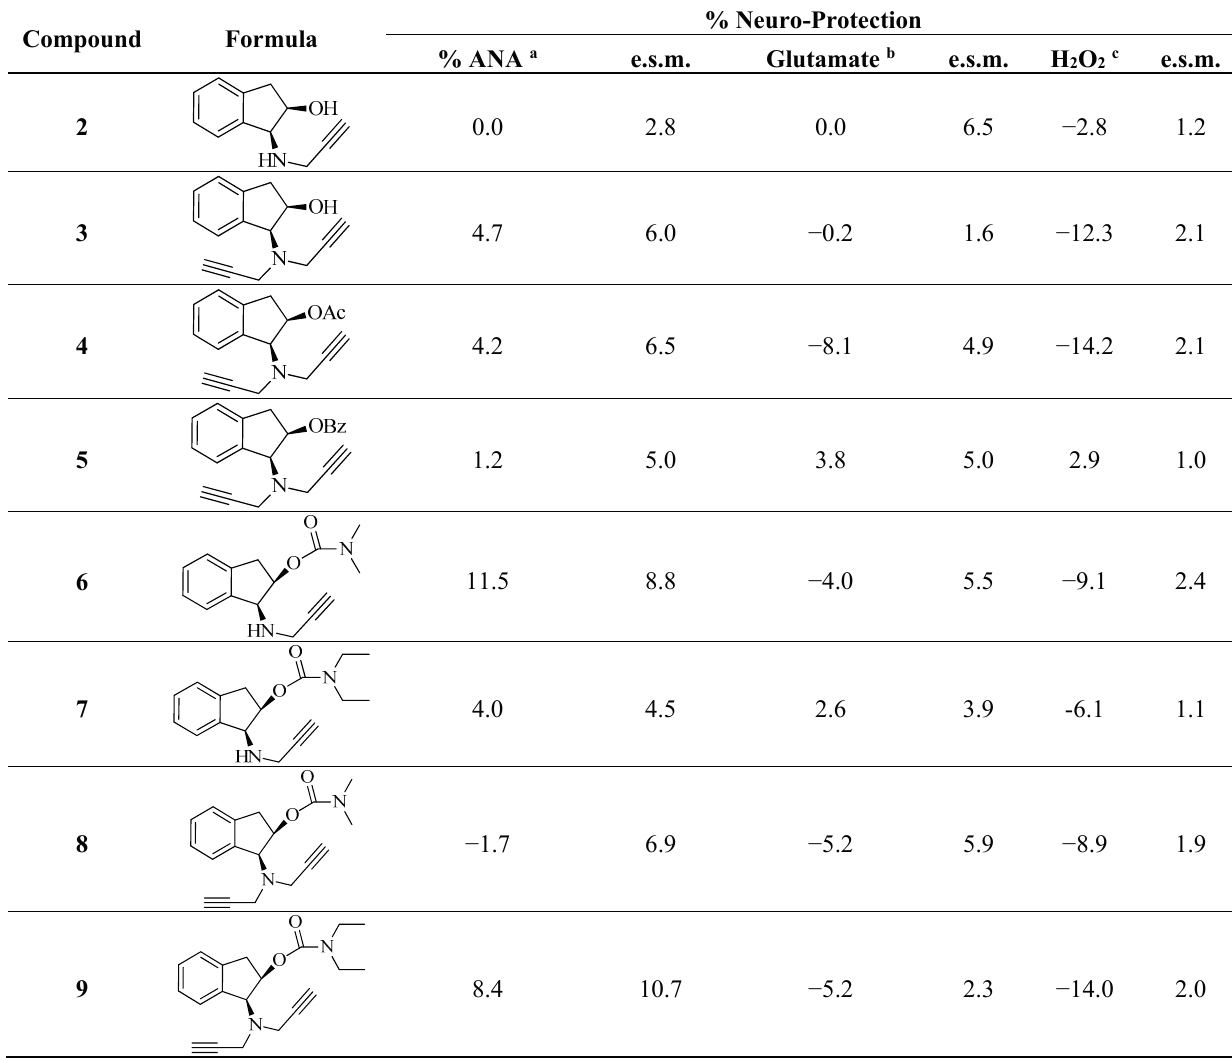
Table 5. Neuroprotective ability of the new 1,2-rasagiline